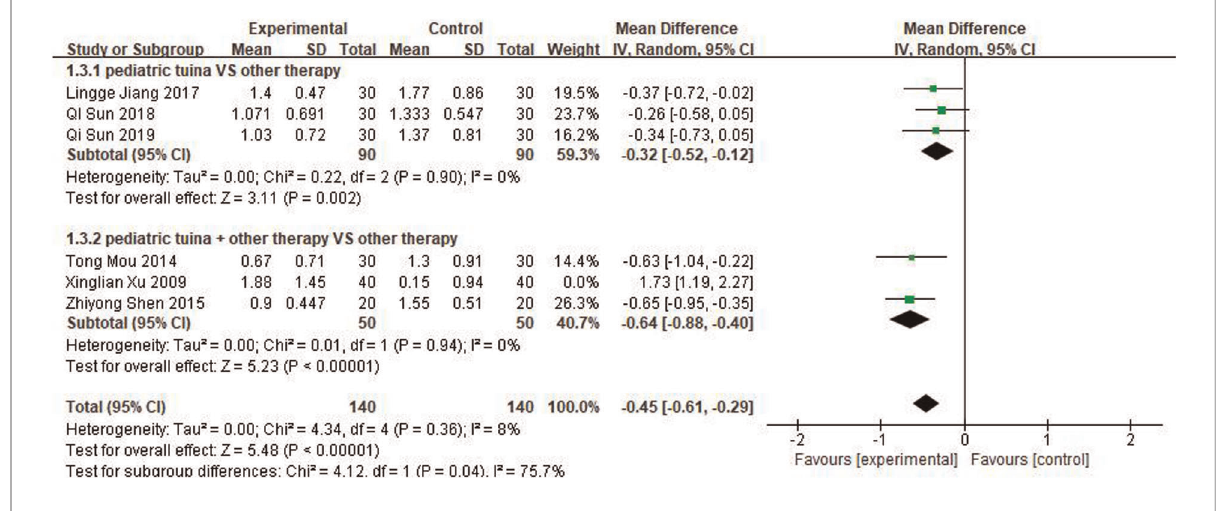
FIGURE 9 Sensitivity analysis of forest plot for the treatment of nasal itching